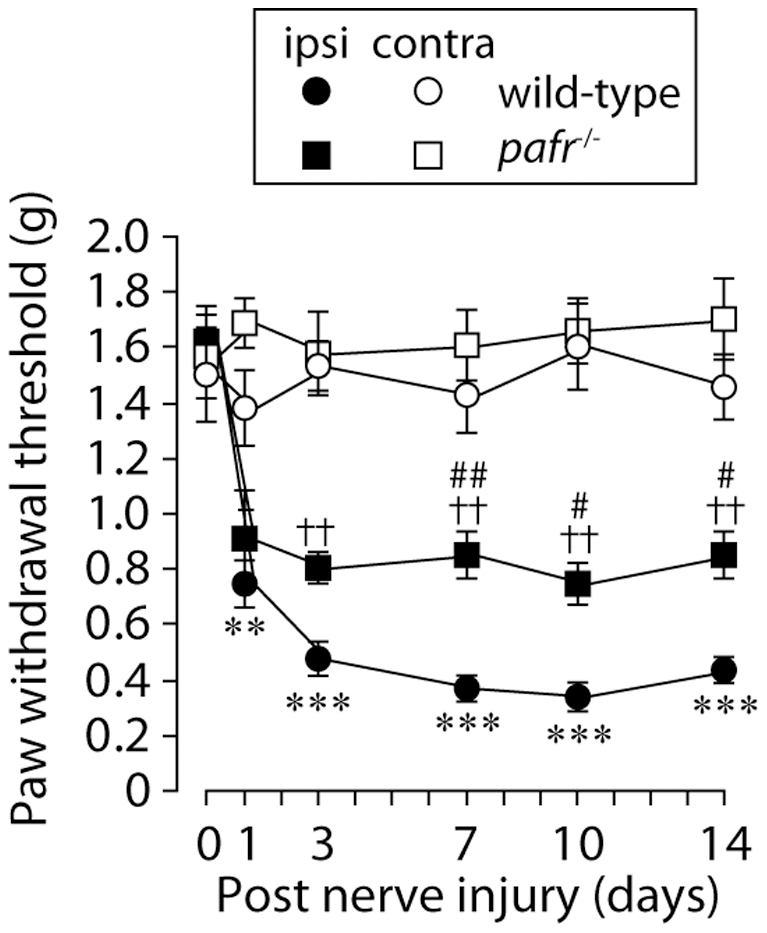
Deletion of pafr reduces tactile allodynia.While wild-type mice with an L5 nerve injury showed a progressively decreased paw withdrawal threshold, pafr
−/− mice showed an attenuation of the decrease in paw withdrawal threshold after nerve injury. **p<0.01, ***p<0.001 compared with the threshold of wild-type mice on day 0. ††p<0.01 compared with the threshold of pafr
−/− mice on day 0. #p<0.05, ##p<0.01 compared with the threshold of the wild-type mice at each time point. All data are presented as mean ± SEM of six to eight animals.